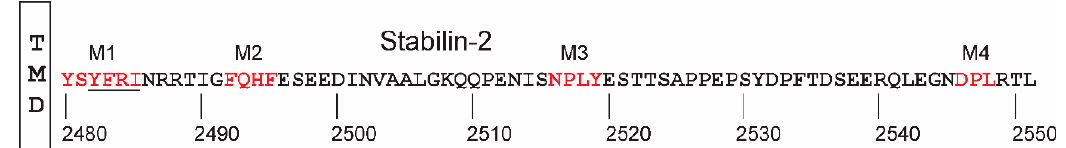
Figure 5. Cytoplasmic domain of Stabilin-2. The red lettered domains for Stabilin-2 have been extensively characterized in the 190HARE protein expression system and are known to assist with receptor endocytosis and signaling.